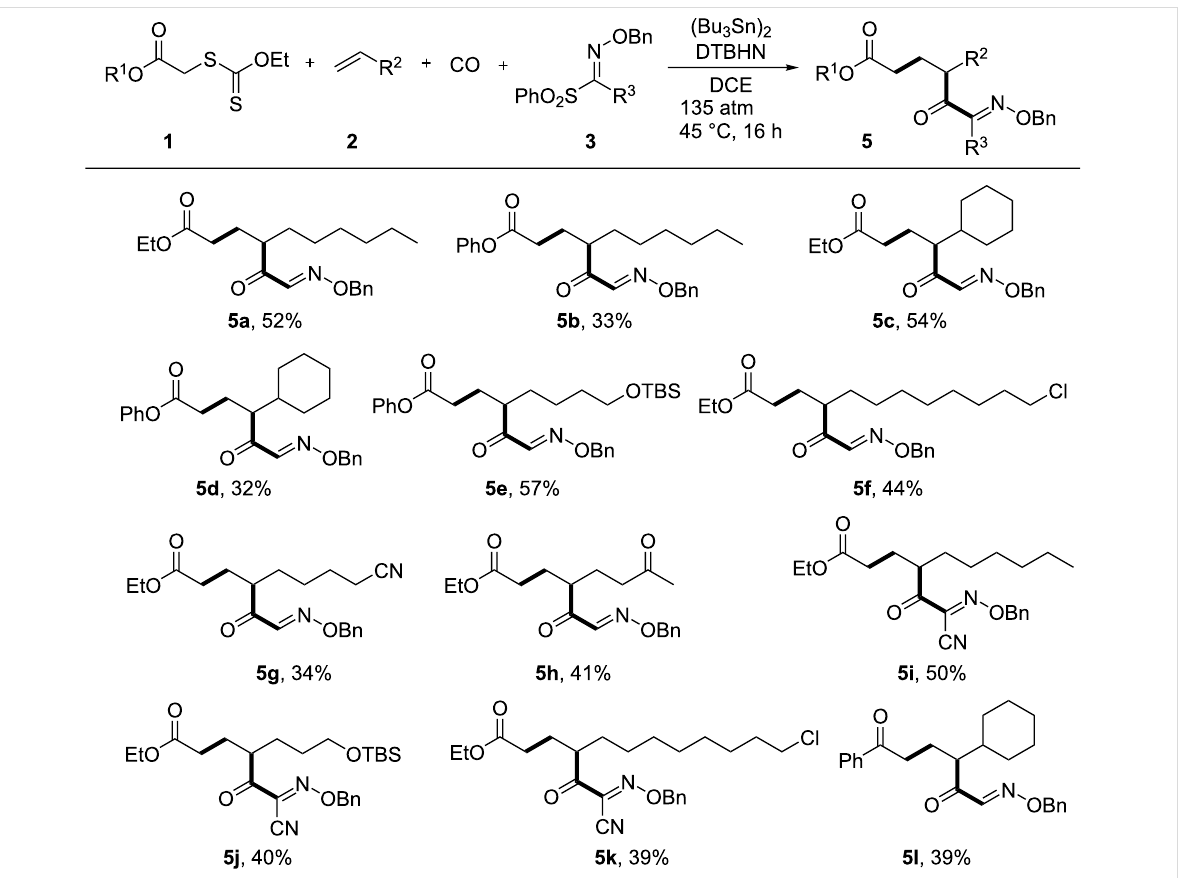
Figure 1: Vicinal difunctionalization of alkenes by four-component radical cascade reaction using xanthogenate 1 , alkenes 2 , CO, and sulfonyl oxime ethers 3 leading to 5a–l . Reaction conditions: 1 (0.4 mmol), 2 (4 mmol), CO (130 atm), 3 (0.5 mmol), DTBHN (30 mol %), (Bu 3 Sn) 2 (0.8 mmol), DCE (8 mL), 45 °C, 16